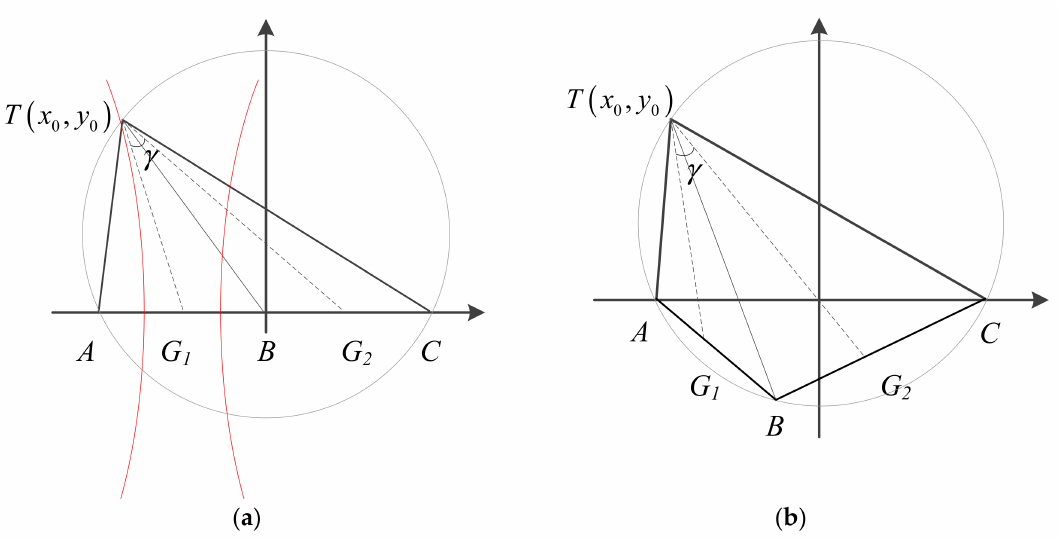
Figure 3. Relationship between intersection angle of two groups of hyperbolic curves and base line AC: ( a ) Line layout by A, B, C; ( b ) Triangular layout by A, B,